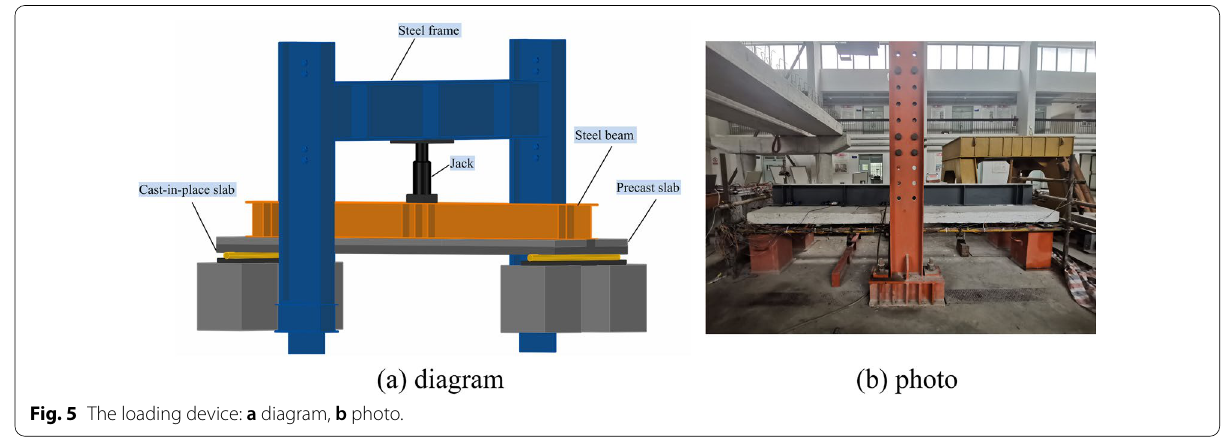
Fig. 5 The loading device: a diagram, b photo.